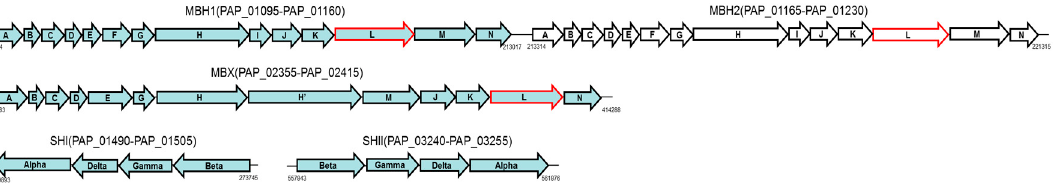
Figure 3. Hydrogenase operons in Pa. pacificus DY20341 including MBH1, MBH2, MBX, SHI, and SHII.The red arrow is the [Ni-Fe] catalytic subunit L to produce H 2 or H 2 S.